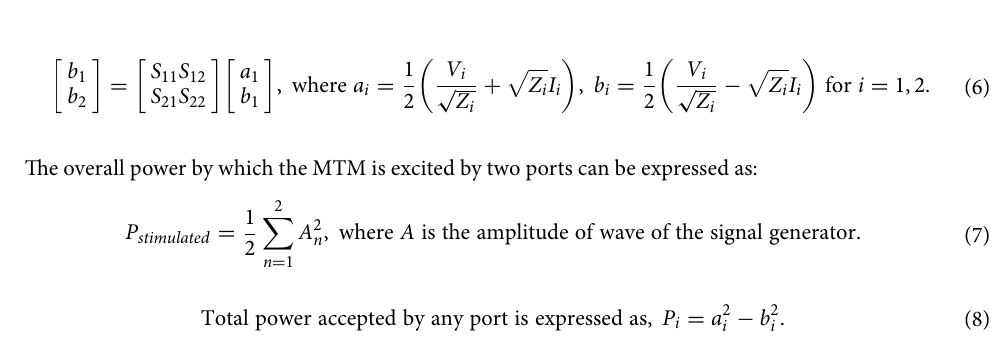
Figure 13. ( a ) Two port system of proposed MTM. ( b ) Power plots for excitation, loss and received at